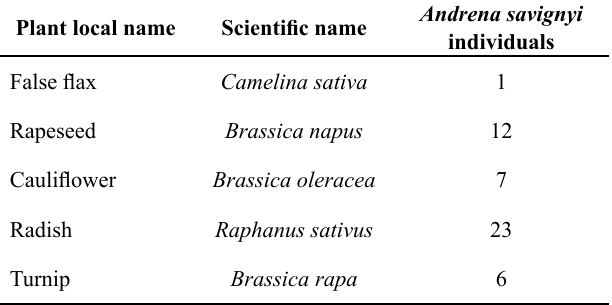
Table 4 . Visitation of A. savignyi on alternate floral resources at Bahawalpur, Punjab,